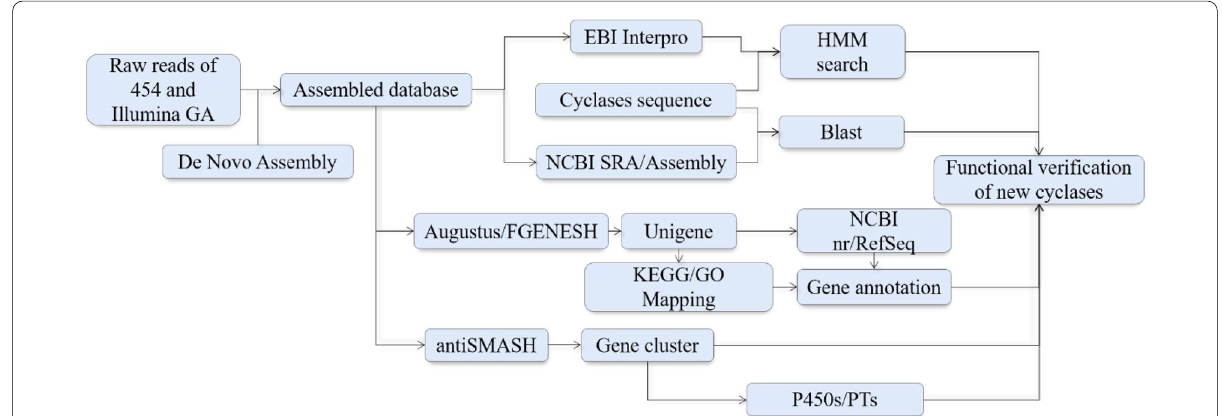
Fig. 4 Genome analysis to discover new terpene synthases. PTs